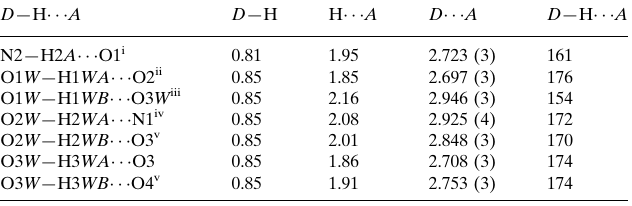
Hydrogen-bond geometry (A˚ , (cid:2)